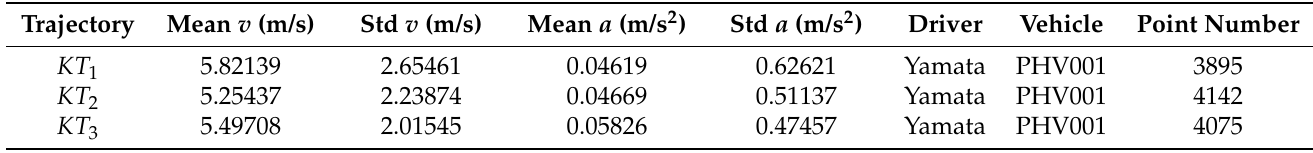
Table 2. The kinematic statistics of the three